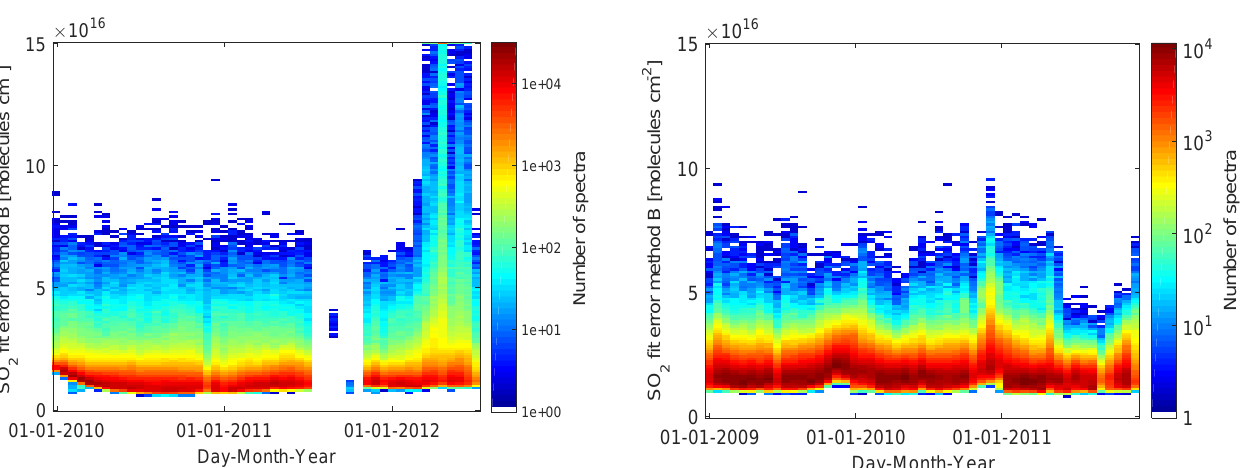
Figure 12. Two-dimensional histogram of the SO 2 DOAS fit error from the solar atlas evaluation as a function time for instrument I2J8548 at